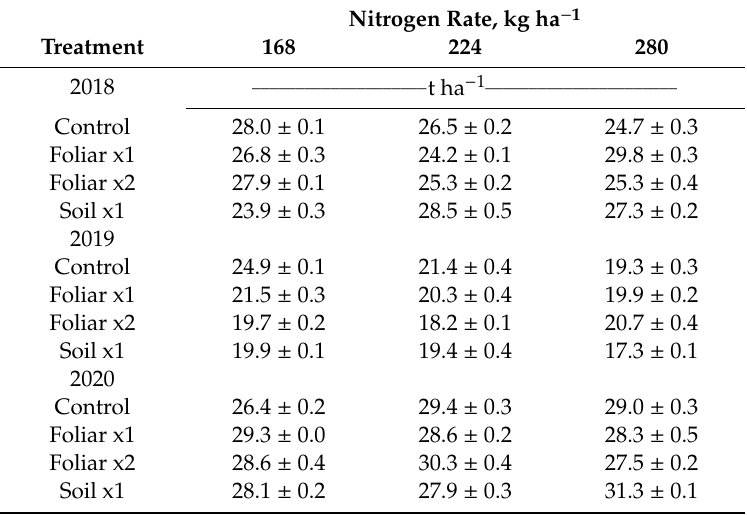
Table 3. Three years of fruit yield of Huanglongbing-a ff ected “Valencia” sweet orange grove with standard error (n = 3) in Lake Alfred,